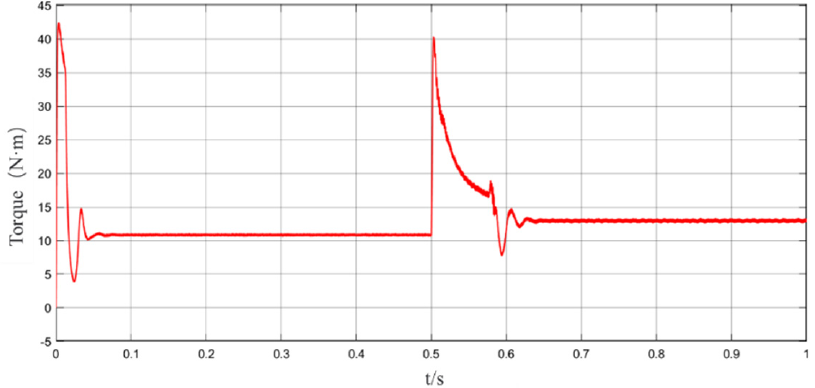
Figure 20. Torque response curve of MRAS algorithm.